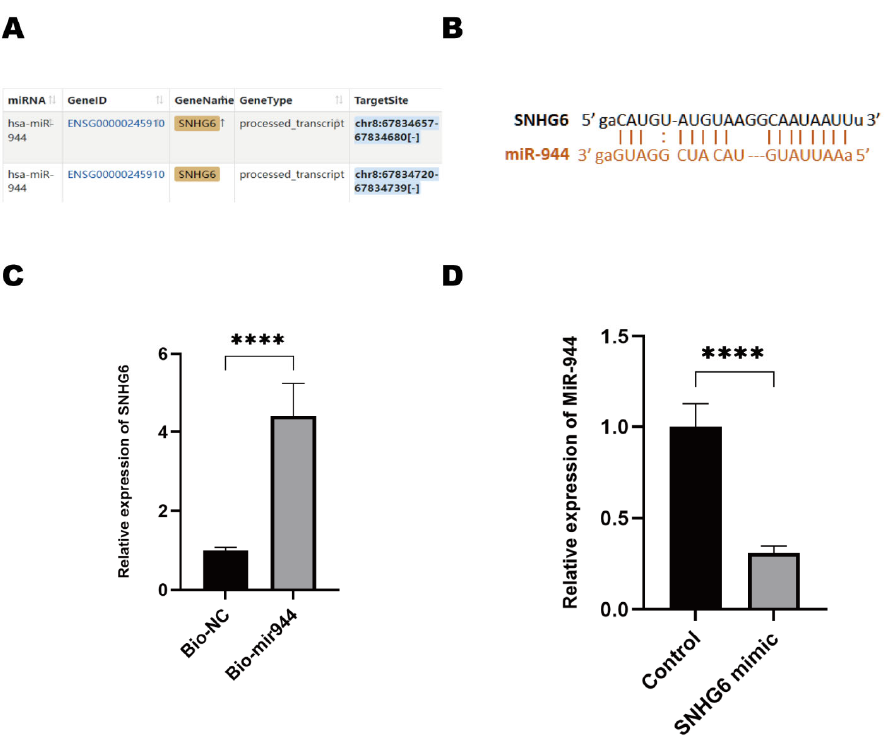
Figure 3. LncRNA SNHG6 acts as a sponge to interact with miR ‐ 944. ( A ) Scheme of the predicted interaction of LncRNA SNHG6 with miR ‐ 944. ( B ) ENCORI prediction of the binding sites between LncRNA SNHG6 and miR ‐ 944. ( C ) Histogram of the PCR assay detecting LncRNA SNHG6 pulled down by biotinylated miR ‐ 944 (bio ‐ miR ‐ 944) or the control (bio ‐ NC), n = 3, ****, p < 0.0001. ( D ) PCR measurement of miR ‐ 944 in PANC ‐ 1 cells that were transfected with LncRNA SNHG6 mimics expressing vectors or control, n = 3, ****, p < 0.0001.